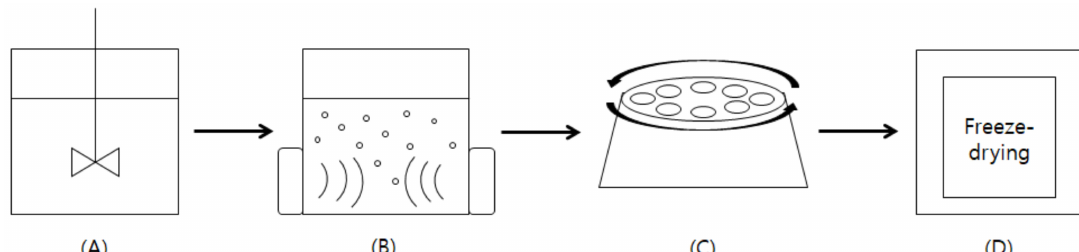
Figure 1. A schematic diagram of ultrasonic extraction process. ( A ) Mixing the aronia fruits with 70% ethanol solvent; ( B ) ultrasonic extraction with various variables in the range of 20 to 100 kHz of input frequency, 2–6 h of process time and 15–35 ◦ C of process time; ( C ) centrifugation of the extract at 4200 g for 10 min to remove the solids; and ( D ) freeze-drying the